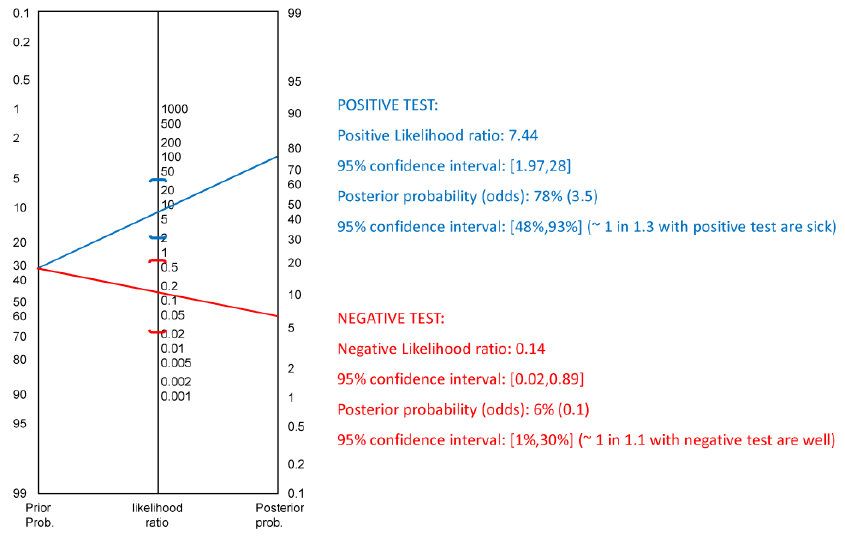
Figure 5. Fagan’s nomogram of the positive and negative LR of the BA5-BA8 theta and alpha connectivity toward MCI differentiation.